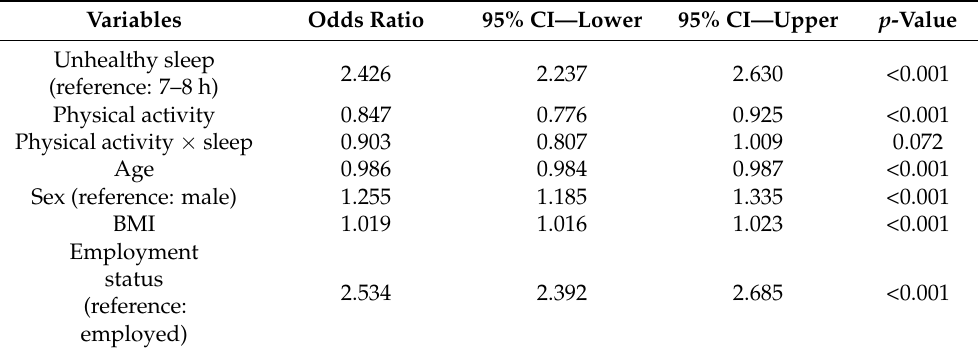
Table 7. The moderating effect of physical activity on the relationship between healthy sleep and emotional distress predictions among Blacks ( n = 46,218).